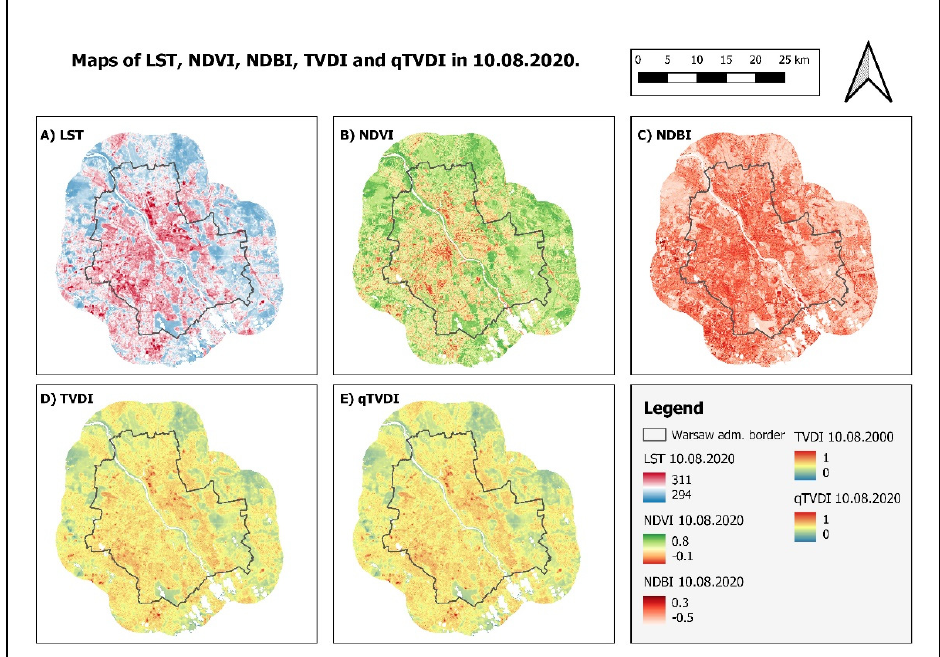
Figure 5. Distribution maps of all analyzed indices over the research area on 10 August 2020